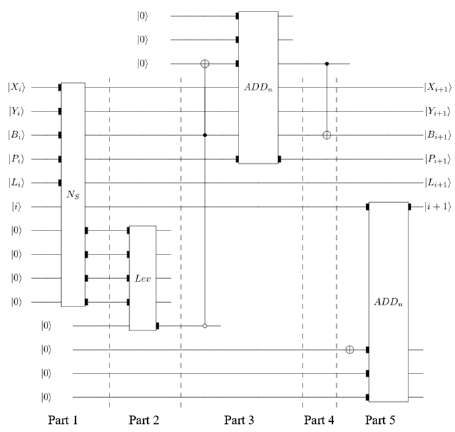
Figure 12. The circuit of Equation (2).